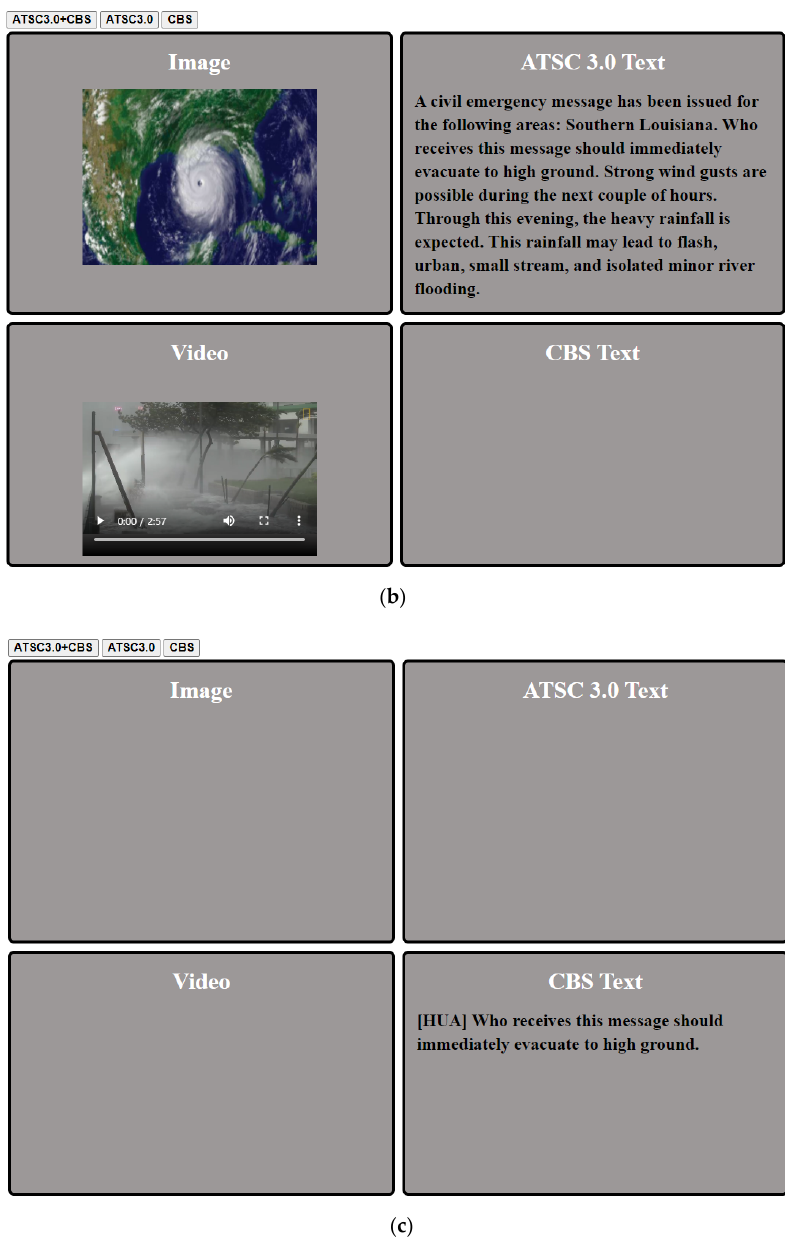
Figure 11. The comparison of terminal displays in the cases of success decoding of both 5G CBS and AEA messages, success decoding of only 5G CBS message, and success decoding of only AEA message for the proposed broadcast approach. We implemented the illustration of Figure 11 using HTML5. Therefore, the illustration of Figure 11 can be displayed on the screens of various platforms including smartphones. ( a ) shows the terminal display in the case of success decoding of both 5G CBS and AEA messages. As illustrated in ( a ), the terminal display includes the long text such as guideline, the image, the multimedia content of the AEA message as well as the short text of the CBS message. Therefore, even illiterate or foreign persons can easily recognize the emergency type such as earthquake or hurricane. ( b ) illustrates the case that the receiver failed in decoding the CBS message. As shown in ( b ), the sub-window for CBS text is blank. However, users can still achieve abundant emergency information from the AEA message. ( c ) illustrates the case that the receiver failed in decoding the AEA message. The sub-windows for AEA message are blank in ( c ). In this case, users can just achieve a limited emergency information from the CBS message. However, the information is still useful for most